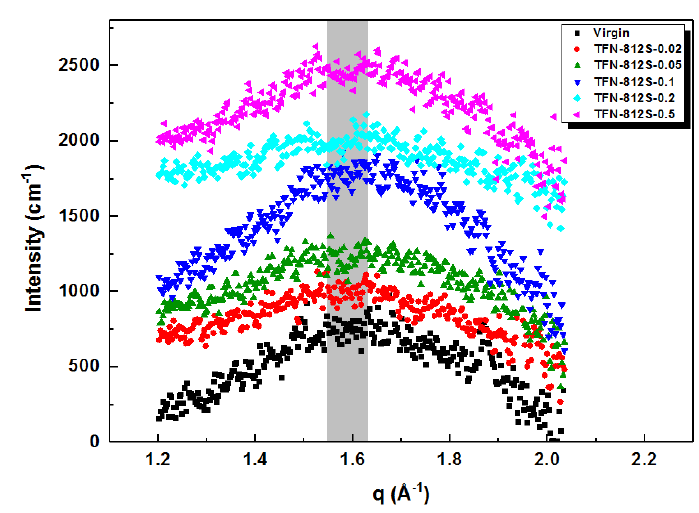
ff erent concentrations of R812S NPs.